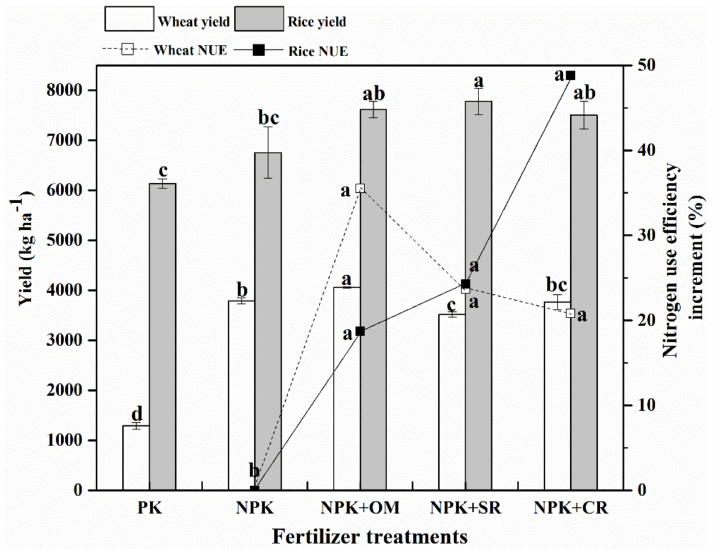
Figure 1. Wheat and rice grain yield and agronomic nitrogen use efficiency (NUE) increment under different fertilizer treatments. (OM = organic manure; SR = straw returning; CR = controlled-release fertilizer). Different letters between treatments represent significant differences at p <